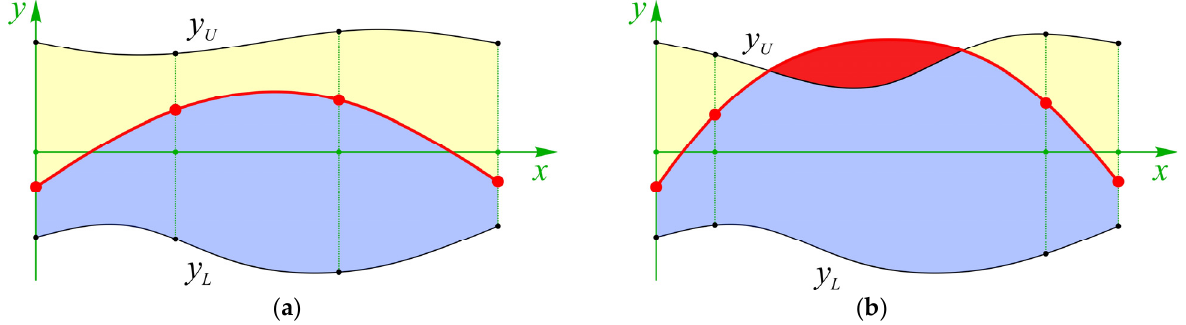
Figure 2. Integral approach to boundary conditions: ( a )—requirement is satisfied, ( b )—requirement is violated.